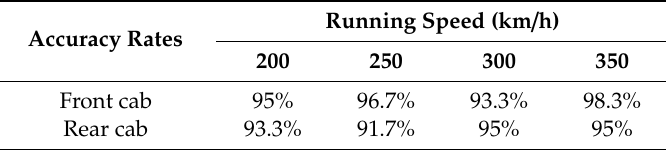
Table 7. Accuracy rates at each speed.